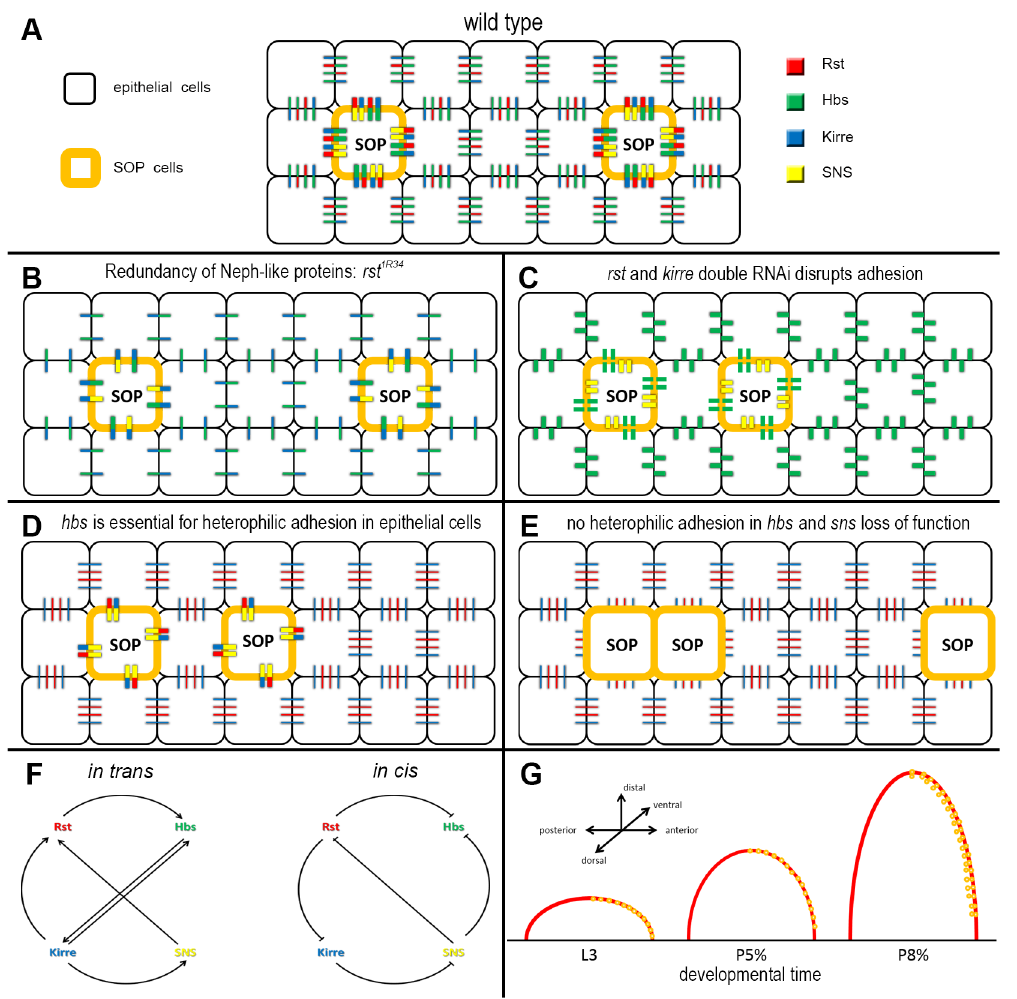
Fig 6. Model of IRM-protein interactions in the Drosophila anterior wing margin. (A-E) Illustration of IRM-protein functions in the anterior wing margin. In black are epithelial cells shown, while SOPs are shown in orange. Protein interactions are shown in different sizes according to the strength of the interaction. Red represents Rst, green Hbs, blue Kirre and SNS is shown in yellow. In the wild type (A) preferred adhesion was observed between the SOPs and the surrounding epithelial cells. Epithelial cells are additionally stable connected through the Hbs, Rst and Hbs, Kirre interaction. In rst 1R34 (B), as an example for Neph-like loss of function, preferential adhesion can still be observed between the SOPs and epithelial cells through the SNS, Kirre and Hbs Kirre interaction. Only in the case of Rst and Kirre loss, the adhesive properties of the wing margin is changed leading to bristle clusters (C). Loss of Hbs prevents heterophilic interaction between the non-SOP cells resulting in mild disturbances of the SOP pattern (D). Loss of Hbs and SNS results in total loss of heterophilic interaction between all cell types in the presumptive anterior wing margin (E). This results in strong disturbances of the SOP and later the bristle pattern (F) Summary of the inductive and competitive interactions between the IRM-proteins in trans and in cis . In the interaction between two cells in trans several inductive events were observed, if these events represent inductions of gene expression or stabilization of proteins in the adhesive belt by heterophilic interactions is currently unknown. Inside cells in cis several competitive interactions were observed, resulting in degradation of proteins in vesicles. Altogether, these interactions allow a precise regulation of IRM-protein abundance and function. (G) Chain model of preferential adhesion of IRM-proteins in the wing disc. The IRM-proteins in the wing disc secure a strong adhesive chain in the distal growing wing. Preferential adhesion around the SOPs secures a constant high number of cells between the SOPs. Growth in distal directions explains the lower number of cells between precursors compared to the adult sensory